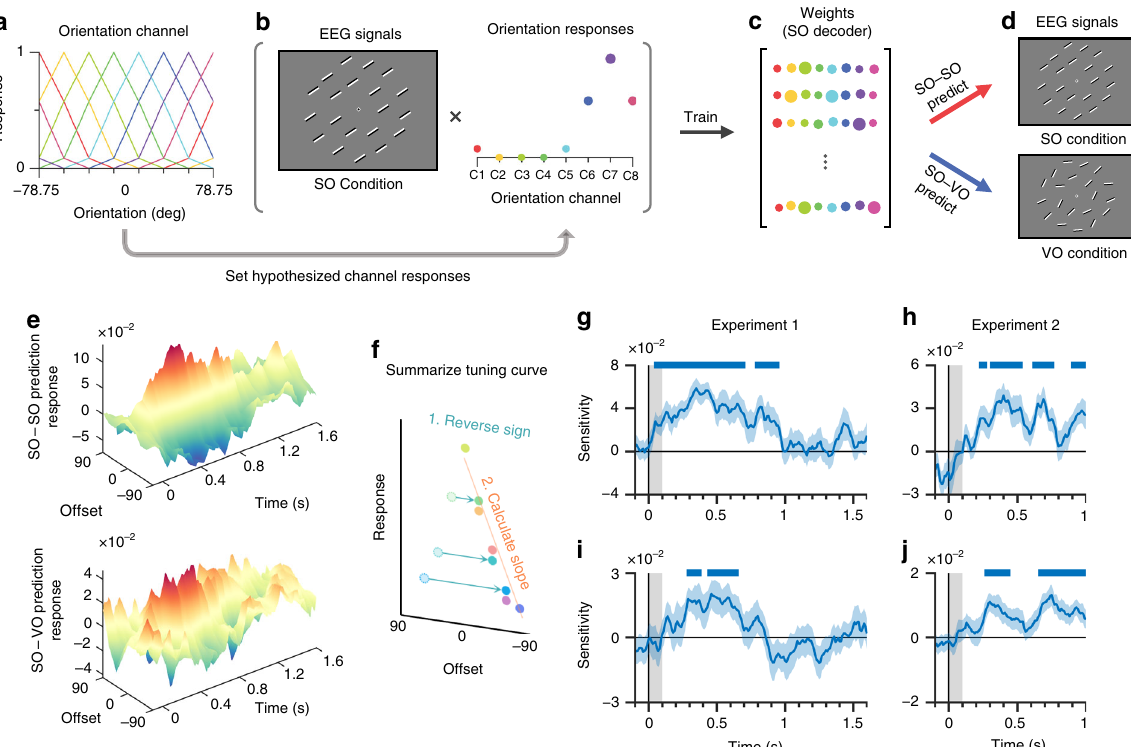
Fig. 3 Illustrations of inverted encoding model (IEM) and procedure. a First, hypothetical orientation-tuning functions were made for the eight orientation channels, respectively. b These hypothetical orientation-tuning functions were then fed into the orientation responses in each trial of the SO condition. c The EEG signals and orientation responses of the SO condition were used to train the weight matrix, which is termed the SO decoder. d The SO decoder was combined with the EEG signals of the SO and VO conditions to predict the orientation responses of each trial. The SO decoder's prediction of the orientation responses of the SO condition was termed the SO – SO prediction. SO – VO prediction refers to the SO decoder's prediction of the orientation responses of the VO condition. e SO – SO and SO – VO predictions showed that the reconstructed orientation-tuning functions were sharply modulated after the stimulus onset. Top, SO – SO prediction. Bottom, SO – VO prediction. f The orientation-tuning curves were summarized by calculating the slopes of curves. Speci fi cally, we fi rst reversed the sign of orientations. We then calculate the slopes by fi tting the linear regression with intercept. g – h Orientation decoding results of SO – SO prediction during Experiment 1 ( h ) and Experiment 2 ( g ). The orientation sensitivity were sharply increased after the stimuli onset. i – j Orientation decoding results of SO – VO predictions during Experiment 1 ( i ) and Experiment 2 ( j ). The signi fi cant modulations showed the reconstruction of mean orientations. The x -axis shows the time after stimulus onset. The y -axis shows the orientation sensitivity. The gray rectangle from 0 to 0.1 s after the stimulus onset shows the period of the presentation of the stimuli. Blue shaded areas represent ± 1 bootstrapped standard error. Blue bars above the fi gures ( g – j ) show signi fi cant modulation over time, determined by a one-sided Monte Carlo randomization test, p < 0.05. SO same orientation, VO varied